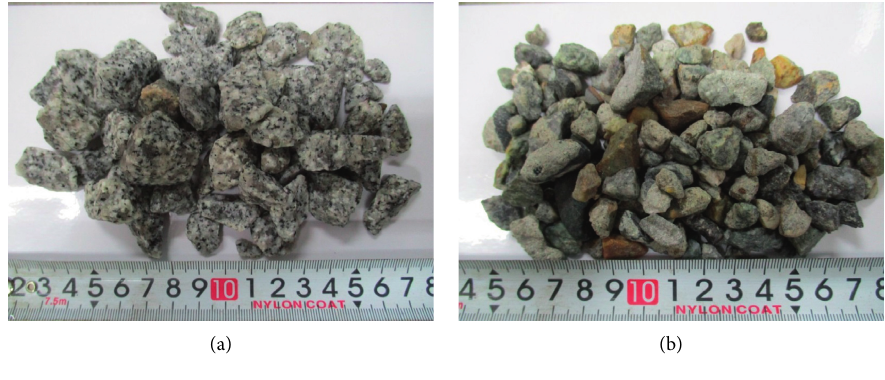
Figure 1: Coarse aggregates. (a) NCAs. (b)